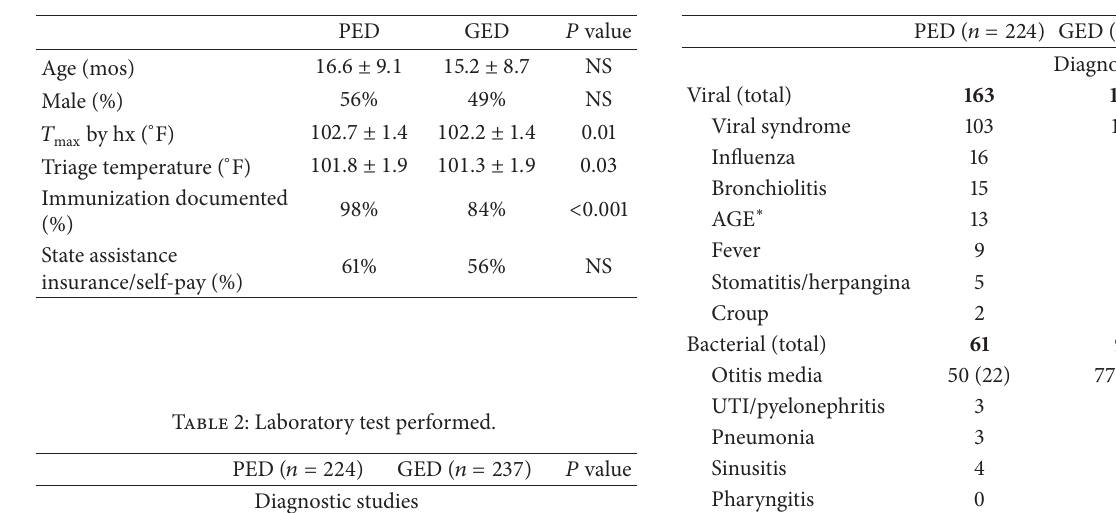
Table 3: Discharge diagnoses and prescription